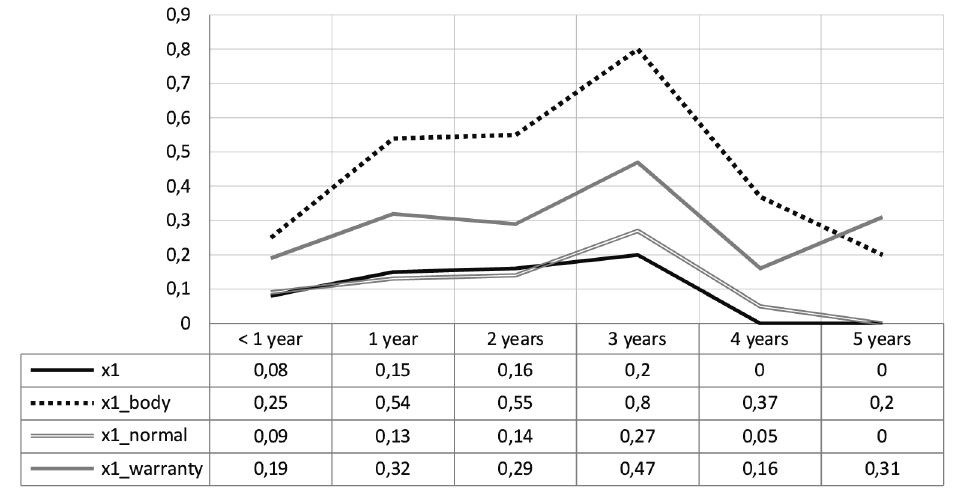
Figure 6. Summary of the SOSE retention indicator in 2018 for the brand x CUS account the years of use of the vehicle and division of the repair order into types